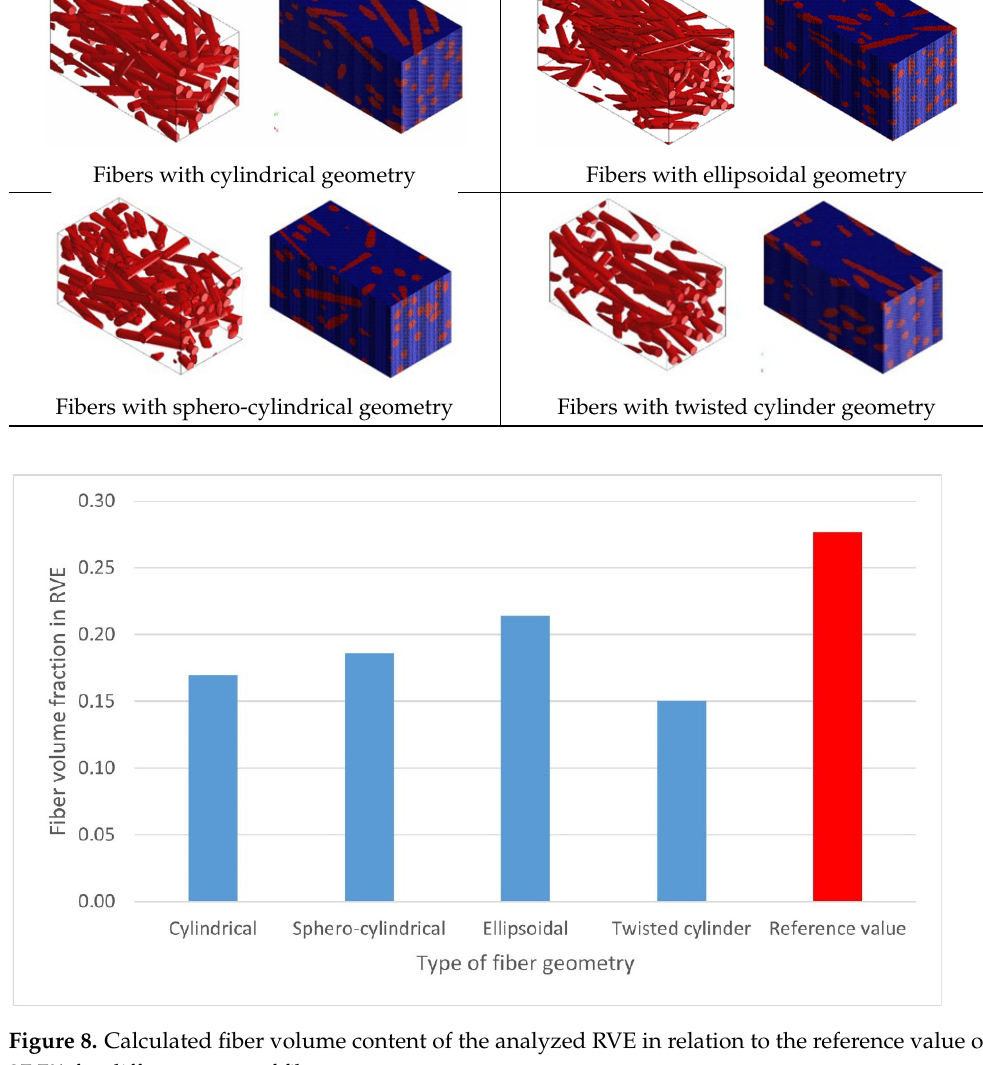
Figure 8. Calculated fiber volume content of the analyzed RVE in relation to the reference value of 27.7% for different types of fiber geometry.